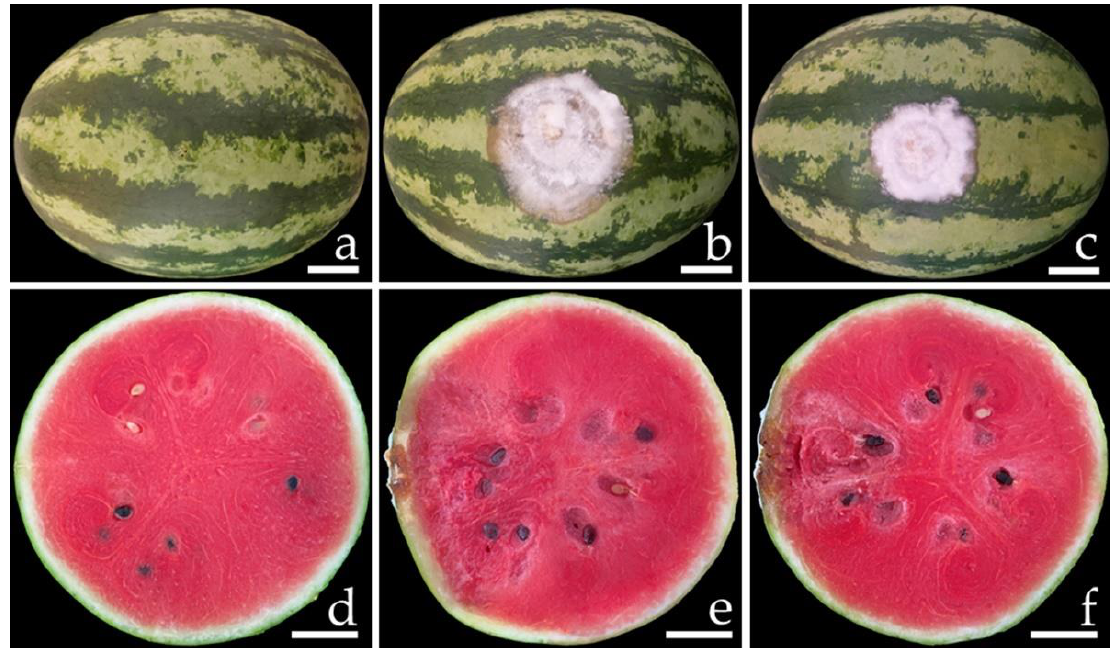
Figure 5. Pathogenicity test using F. citrullicola SDBR-CMU422 and SDBR-CMU423 on watermelon ( Citrullus lanatus ) fruits after one week of inoculation. Control fruit treated with water instead of inoculum ( a , d ). Fruit rot after inoculation of isolate SDBR-CMU422 ( b , e ) and isolate SDBR-CMU423 ( c , f ). Scale bars = 30 mm.